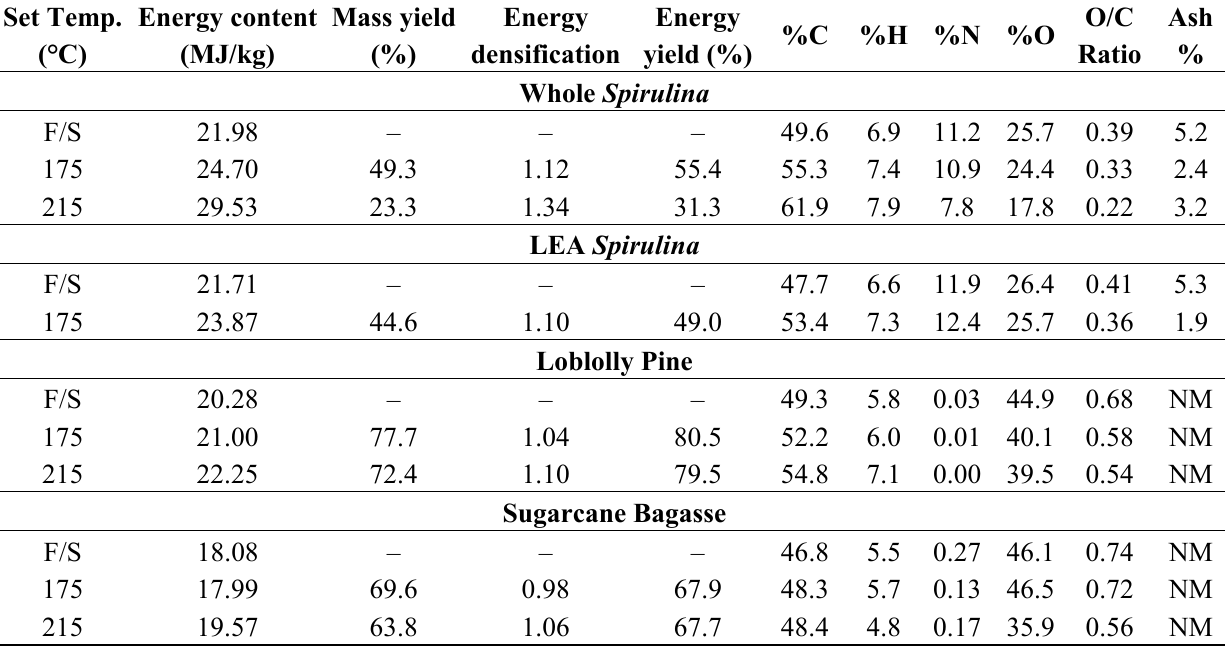
Table 2. Hydrochar recoveries and